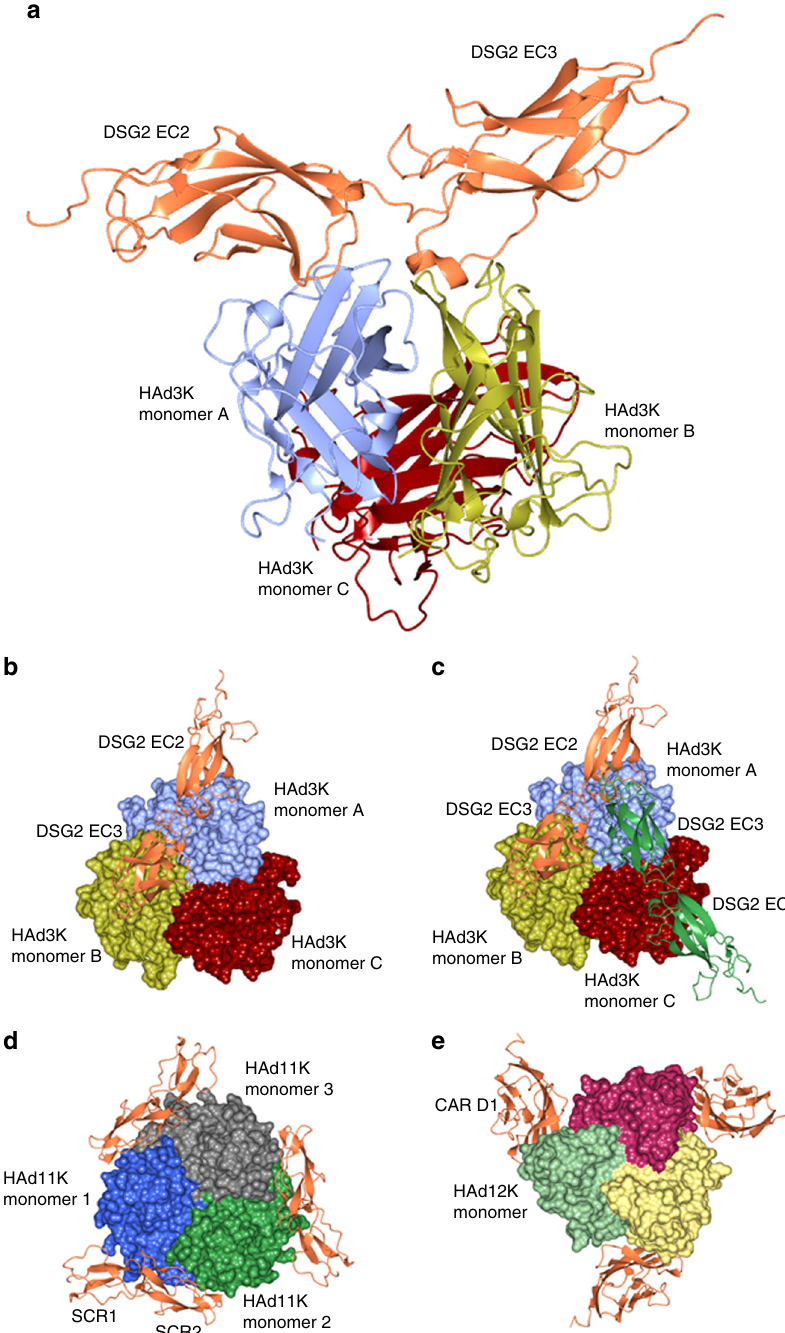
Fig. 1 Atomic reconstruction of HAd3K/EC2-EC3 complex, comparison to CAR and CD46. a Side view of HAd3K/EC2-EC3 complex with the three HAd3K monomers colored in blue, gold and red and EC2-EC3 colored in orange. b Top view of the same complex. c Top view of HAd3K/(EC2-EC3) 2 with the second module in green. d Top view of HAd11 Knob structure with three CD46 SCR1&2 molecules in orange (PDB: 2O39). e Top view of HAd12 Knob with CAR D1 domain in orange (PDB: